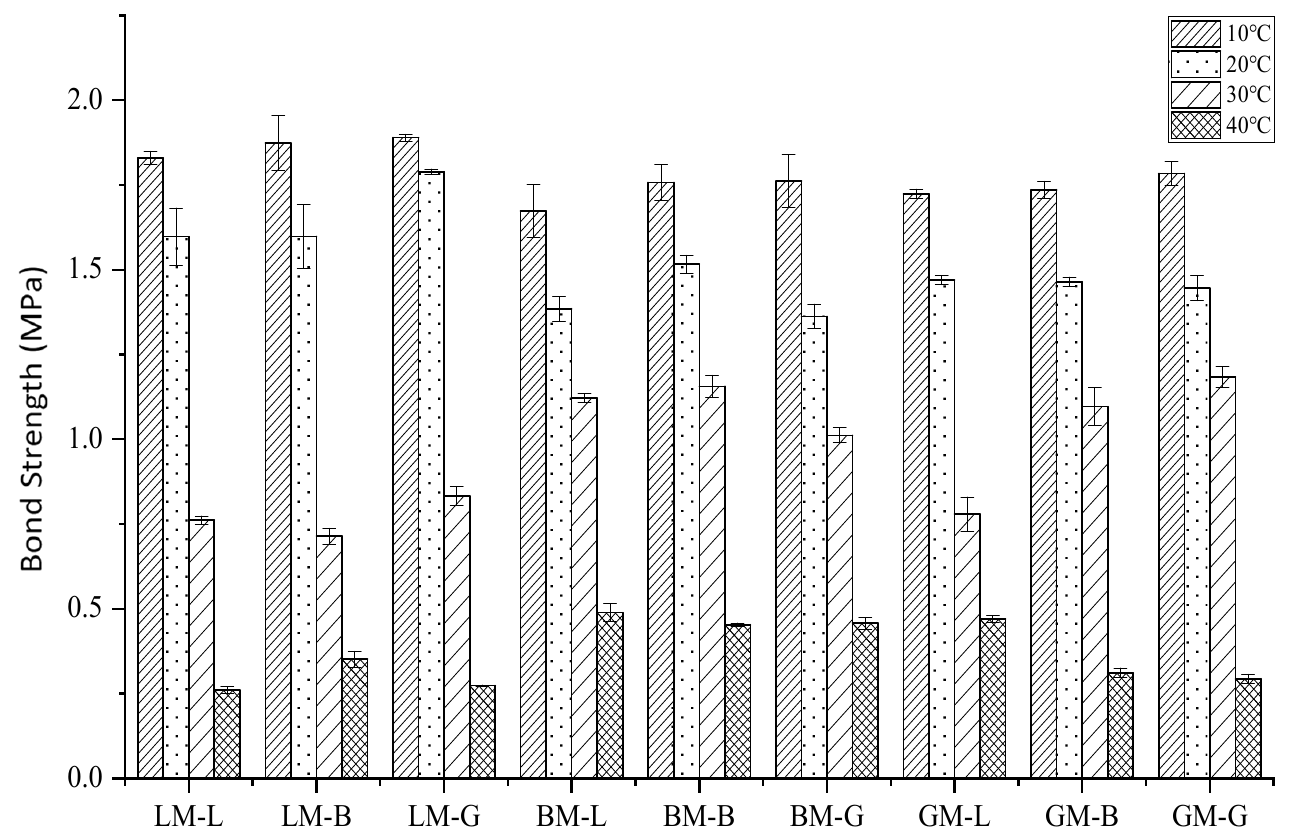
Figure 10. Bond strengths of asphalt mastic–aggregate interfaces at different temperatures.